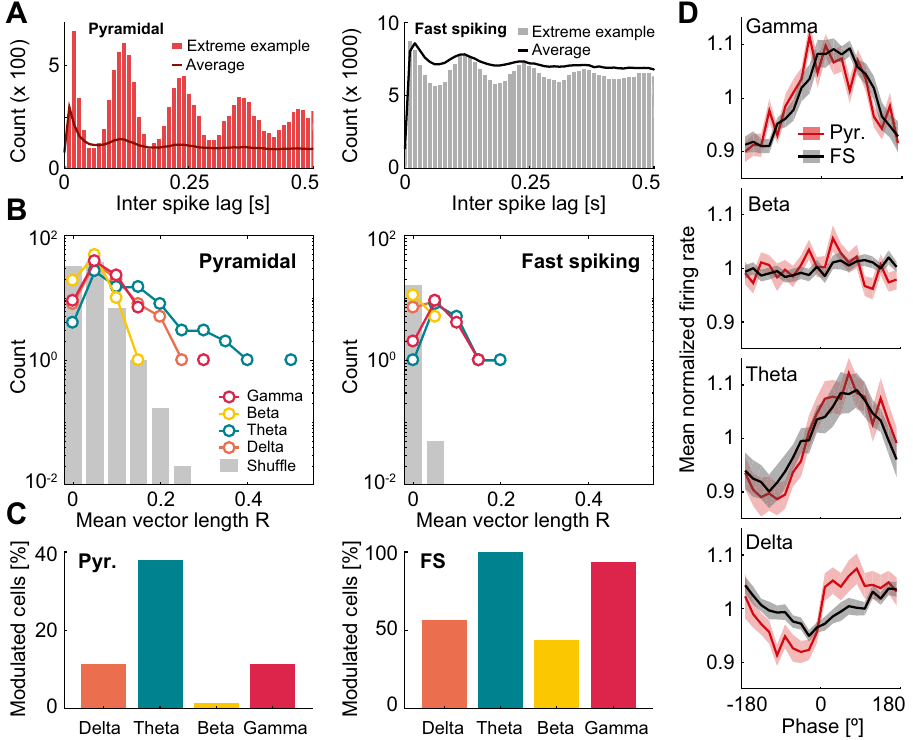
Figure 7. Frequency bands modulate the spiking activity of CA1 neurons. ( A ) Spike-lag histograms for the putative pyramidal (left) and fast spiking (right) cells with strongest theta modulation (bars) together with the population mean for each cell type (line). ( B ) Distribution of mean vector length R for putative pyramidal (left) and fast spiking (right) cells (frequency bands color coded). Grey bars: distribution of the pool of 100 shuffles in spike timestamps per cell. ( C ) Percentage of putative pyramidal (left) and fast spiking (right) cells with significant modulation for each frequency band (same color code). ( D ) Normalized firing rate as a function of oscillation phase for putative pyramidal (red) and fast spiking (black) cells for different frequency bands (from top to bottom: gamma, beta, theta, delta; mean ±